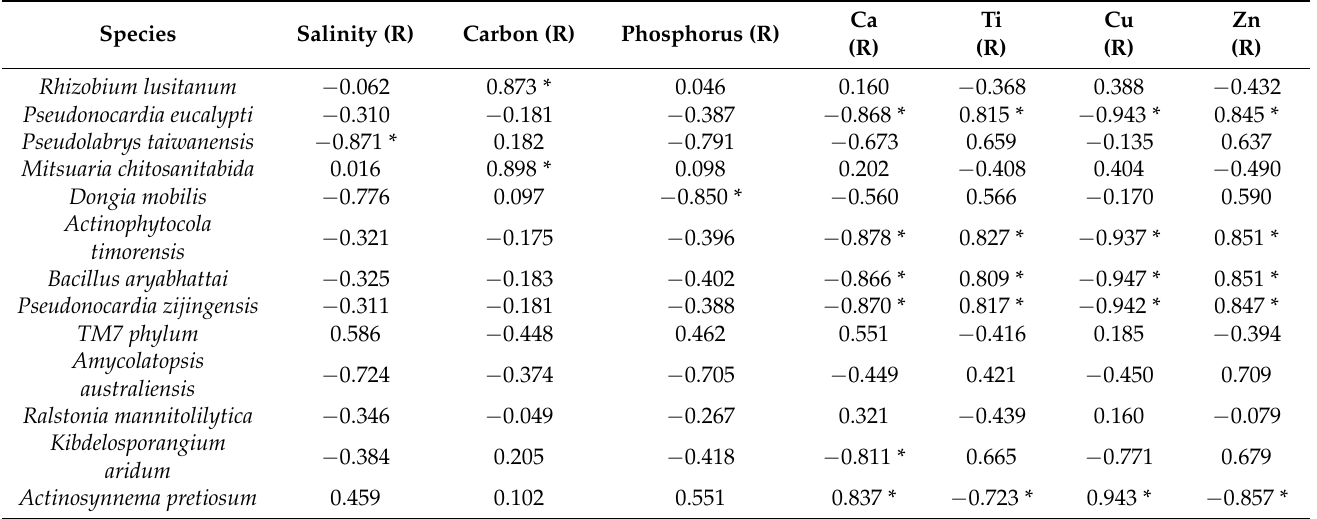
Table 4. Correlation Between Bacterial Abundance Associated with the Root of S. littoreus and Soil